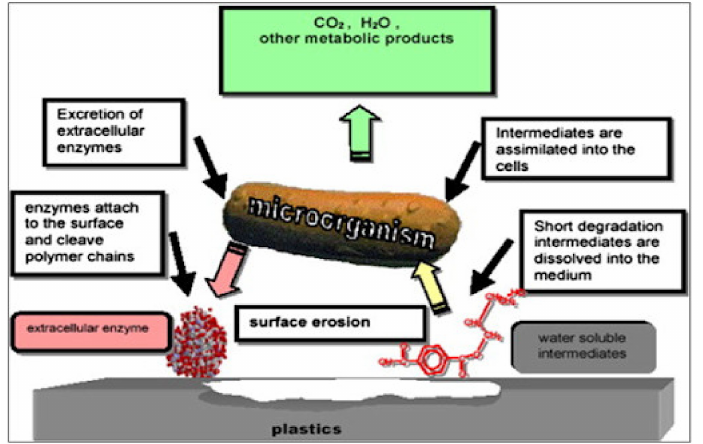
Figure 16. Mechanism plastic degradation by microorganism [151]. Adapted with permission from Sun and Lin